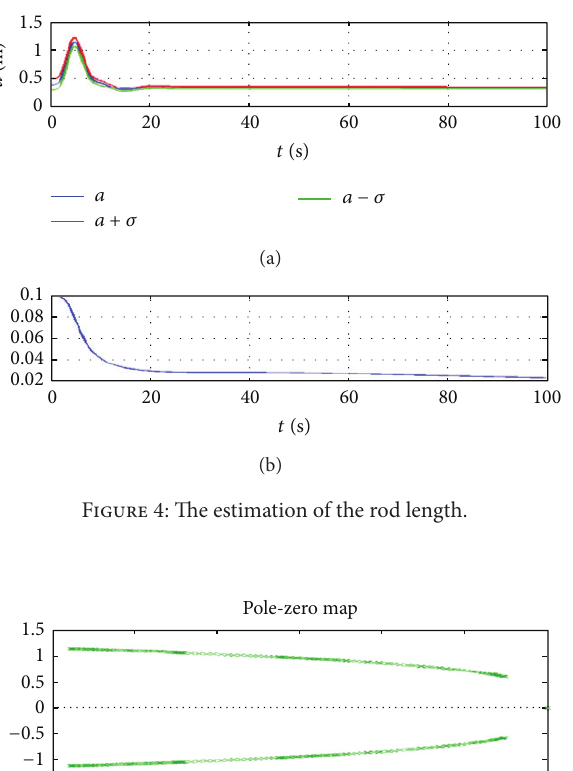
Figure 5: Poles position during the estimation.